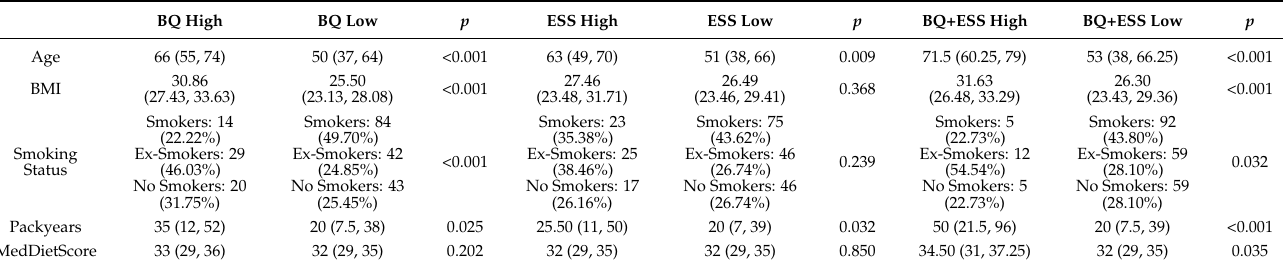
Table 3. High-risk participants for BQ, EDS, and